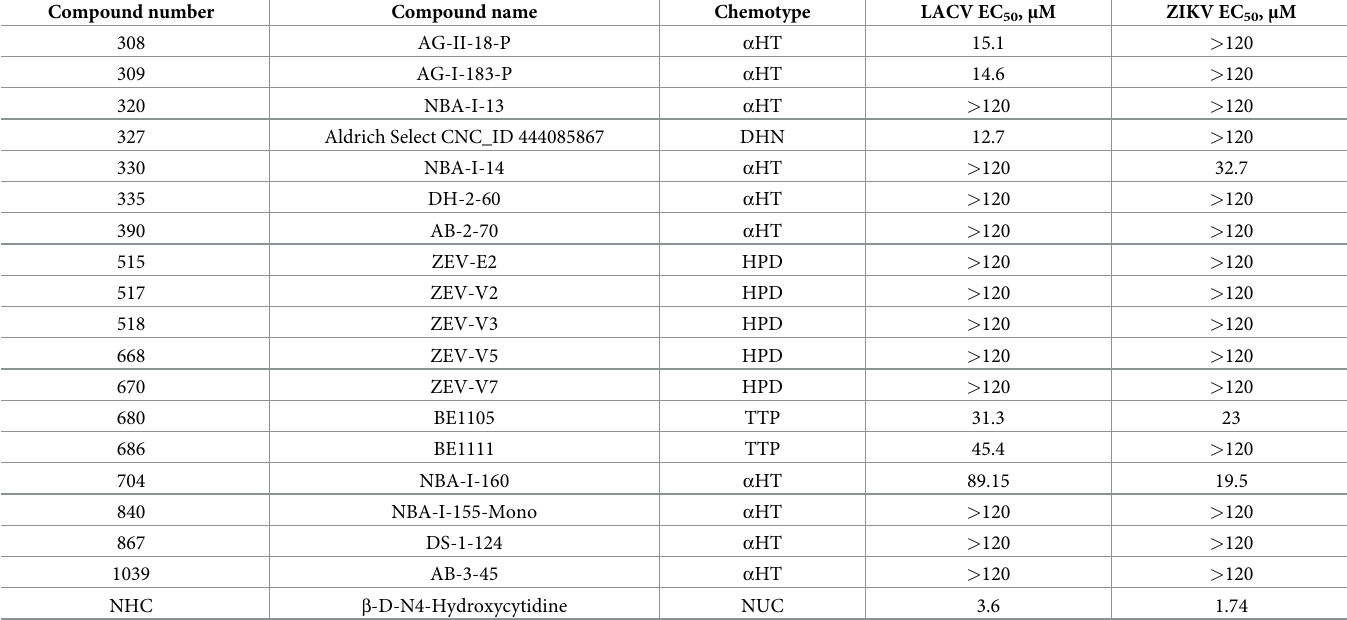
Table 3. EC 50 against LACV and ZIKV